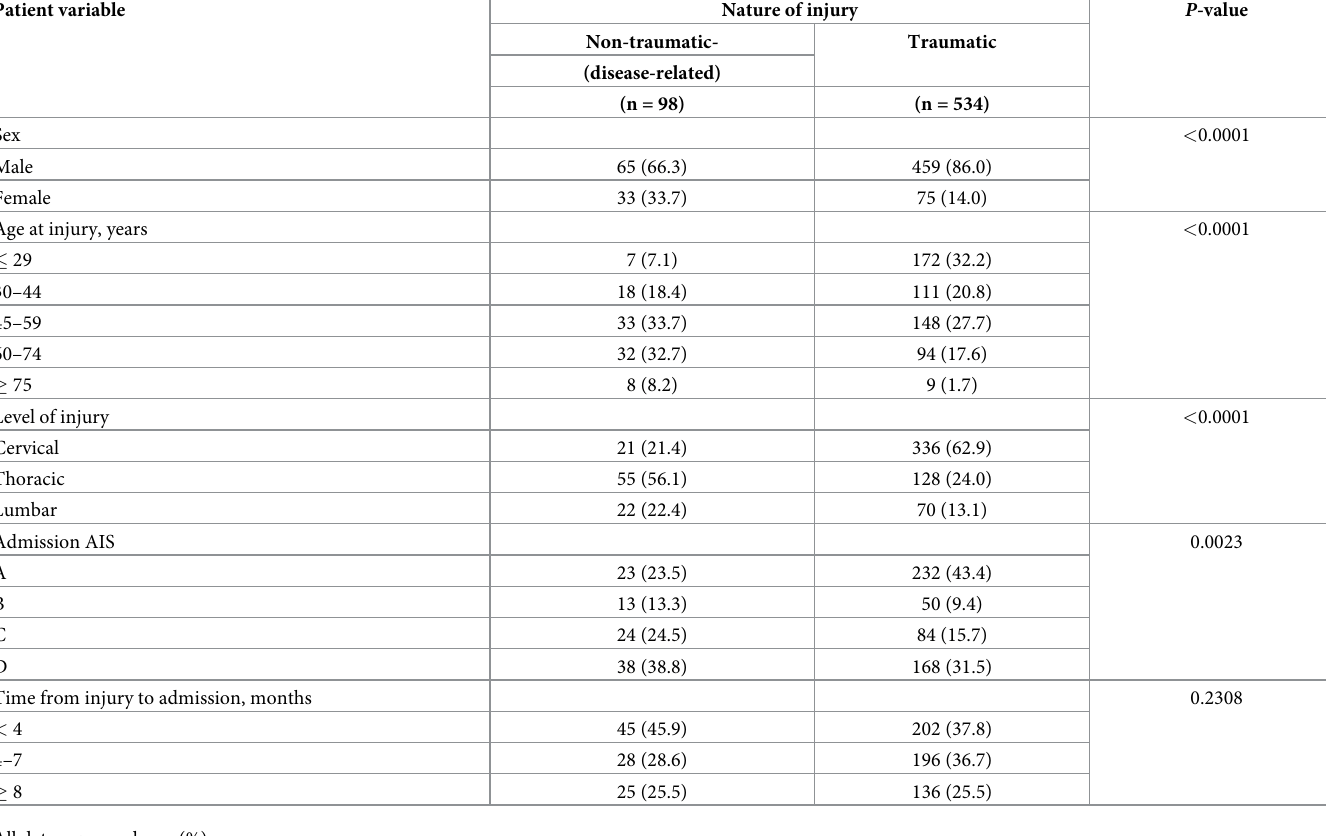
Table 2. Patient comparison by nature of spinal cord